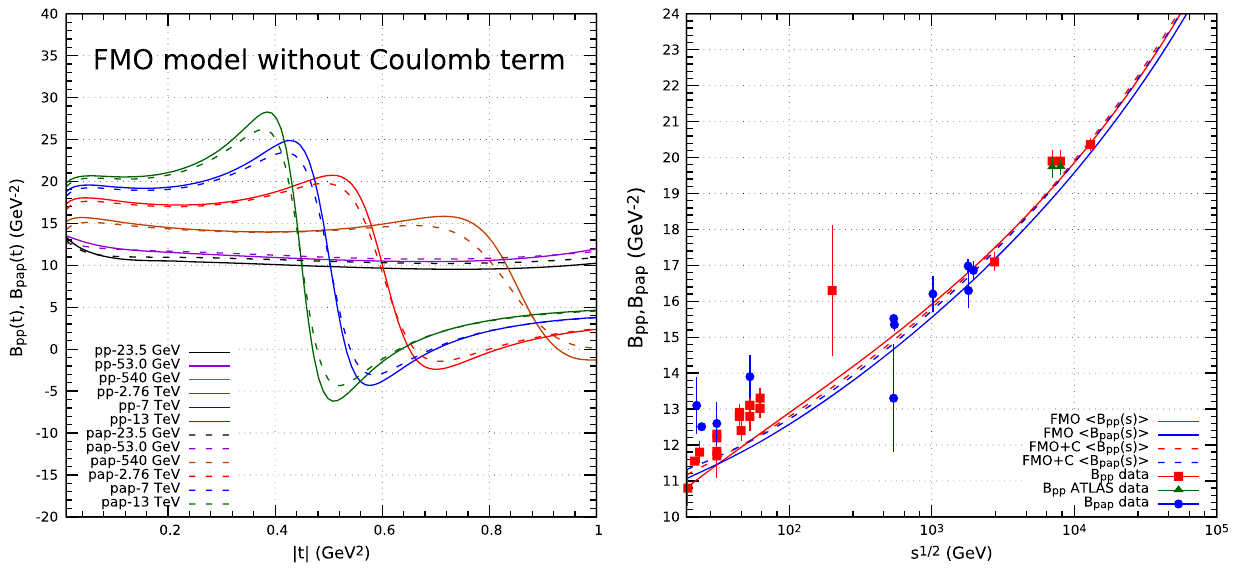
| t | . In Fig. 8, we show in a magnified way the differential cross-sections at 53 GeV.